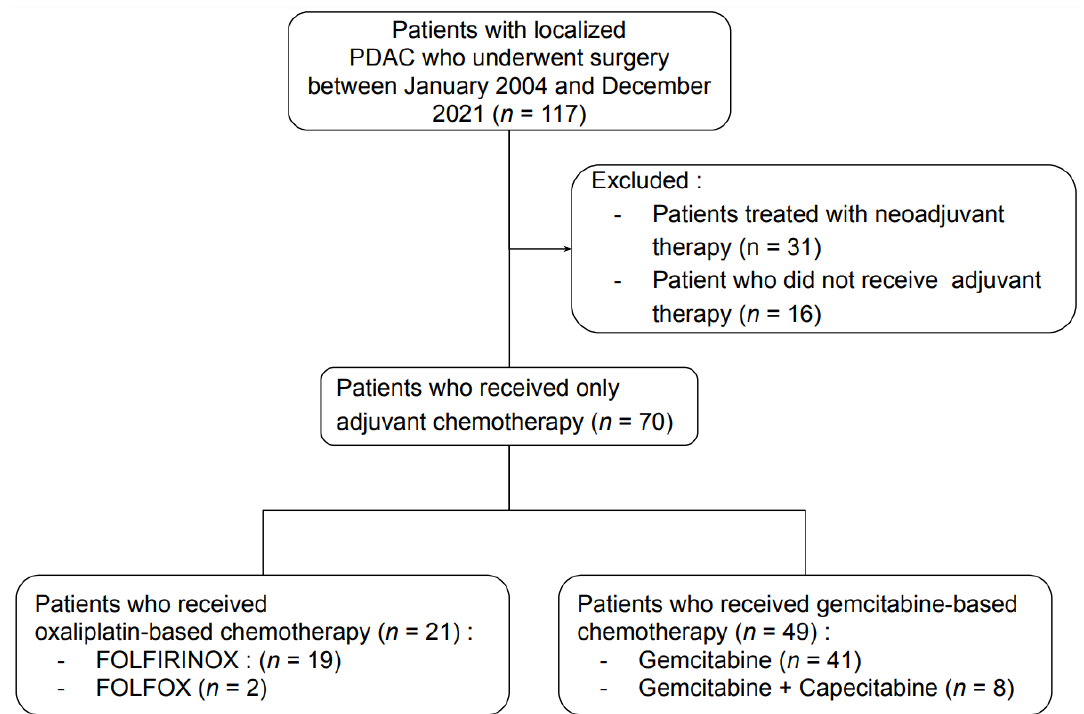
Figure 2. Study flow chart. PDAC indicates pancreatic ductal adenocarcinoma.